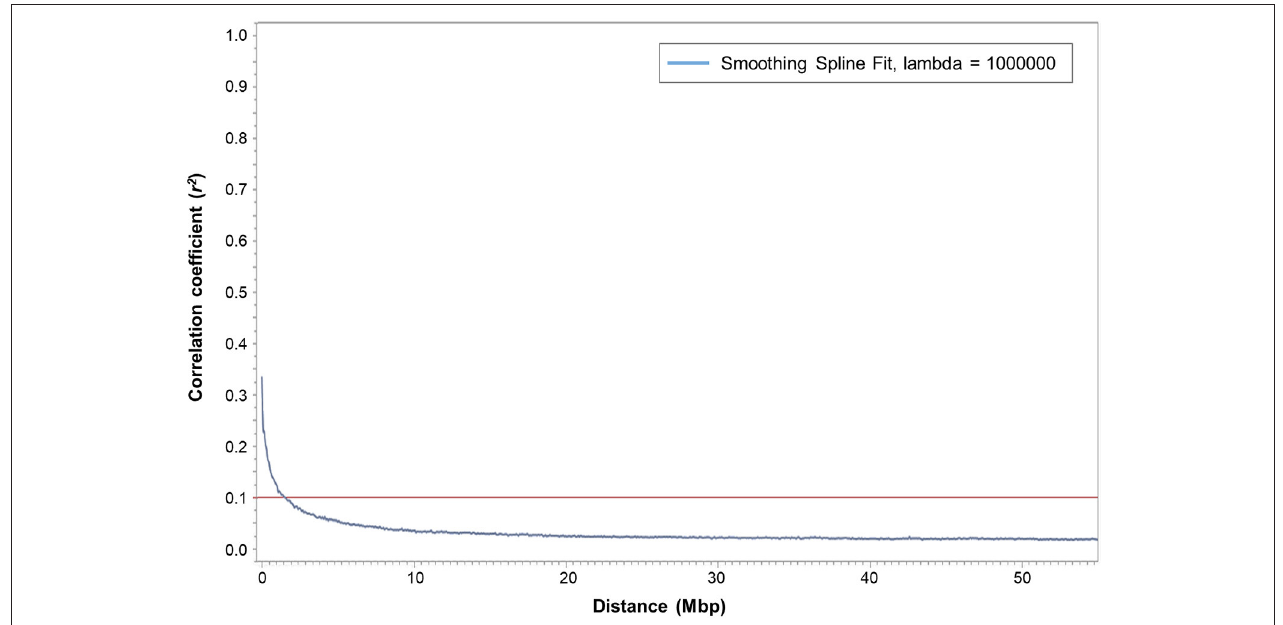
FIGURE 2 | Plot of pairwise SNP linkage disequilibrium (LD) r 2 value as a function of inter-marker genetic distances (Mbp) of 247 spring barley genotypes. The blue curve represents the smoothing spline regression model fit to LD decay. The red line represents the baseline r 2 value at 0.1. The intersection of the fitted smoothing spline and r 2 was observed at around 1,460,356